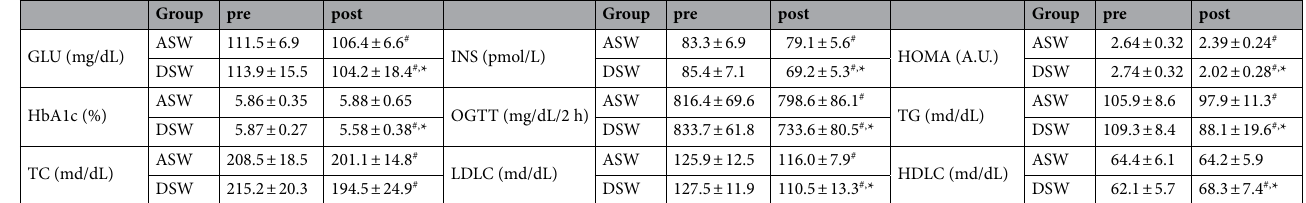
Table 2. Changes (mean ± SD) in resting glucose (GLU) and insulin (INS) concentrations, the homeostasis model assessment (HOMA) index, whole blood glycosylated hemoglobin (HbA1c) concentration, oral glucose tolerance test (OGTT) results, total cholesterol (TC), triacylglycerol (TG), low- (LDLC) and high-density lipoprotein cholesterols (HDLC) concentrations before (pre) and after (post) ascending (ASW; n = 15) and descending stair walking (DSW; n = 15). # : significant ( p ≤ 0.05) difference compared with the pre-training level. *: significant ( p ≤ 0.05) difference compared with the ASW group.